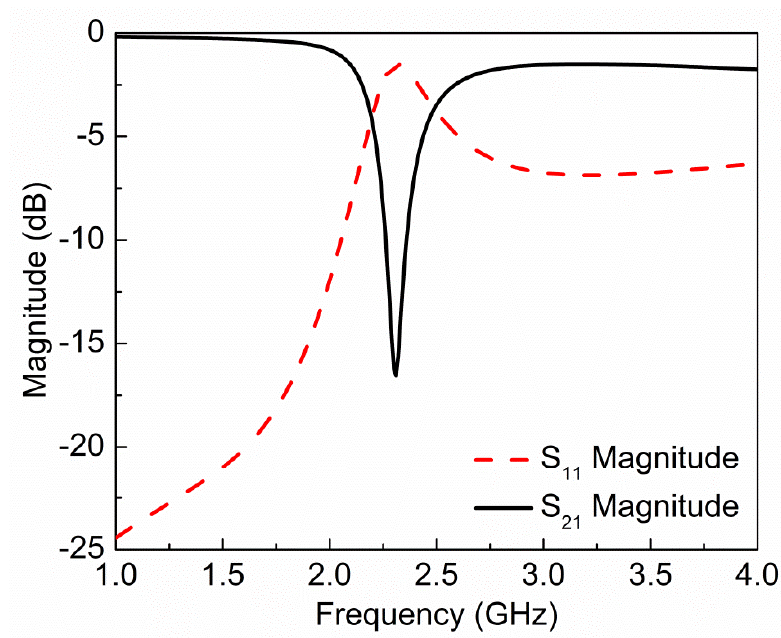
Figure 2. Magnitude of simulated reflection ( S 11 ) and transmission ( S 21 ) coefficient for the proposed sensor. Resonance frequency of sensor is 2.32 GHz with notch depth −16.54 dB.